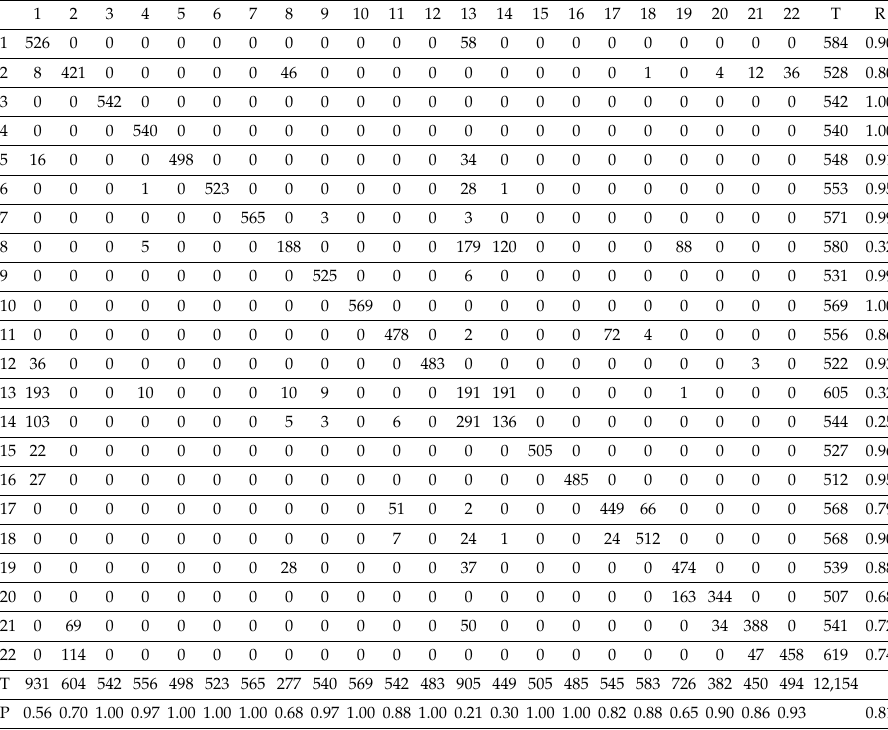
Table A4. The confusion matrix of the proposed